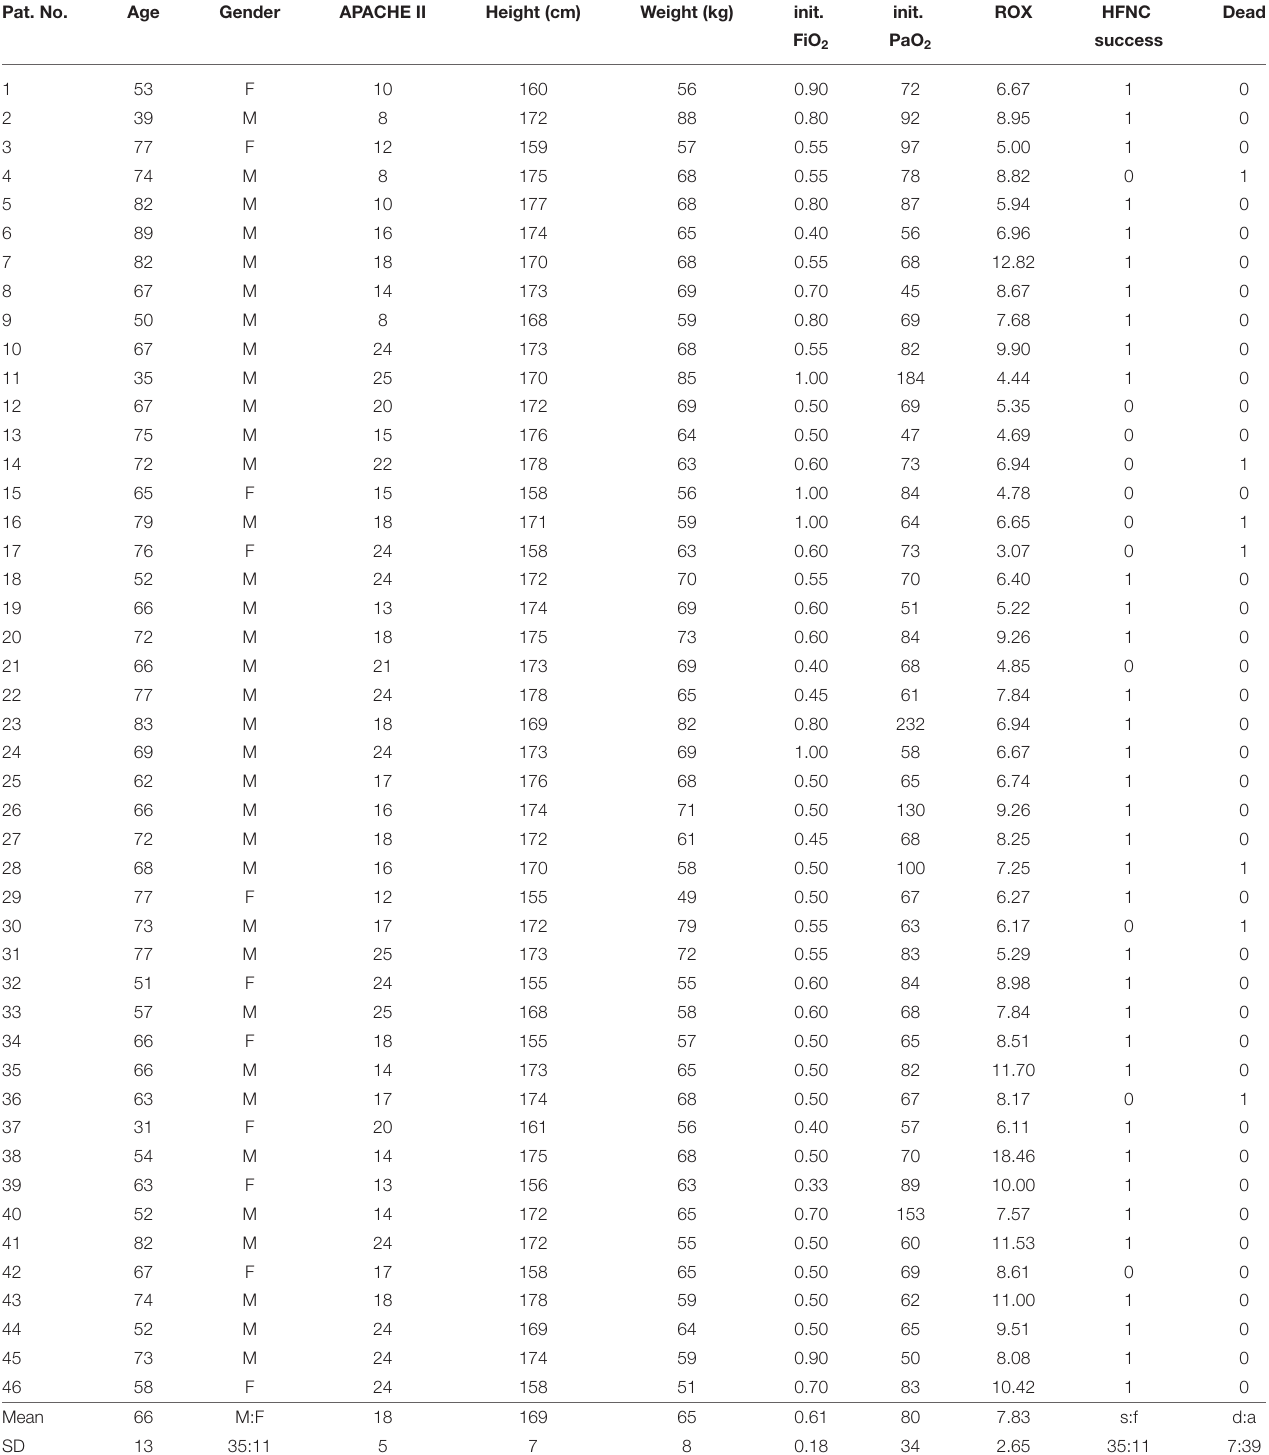
TABLE 1 | Demographics and outcomes of the studied subjects. Pat.